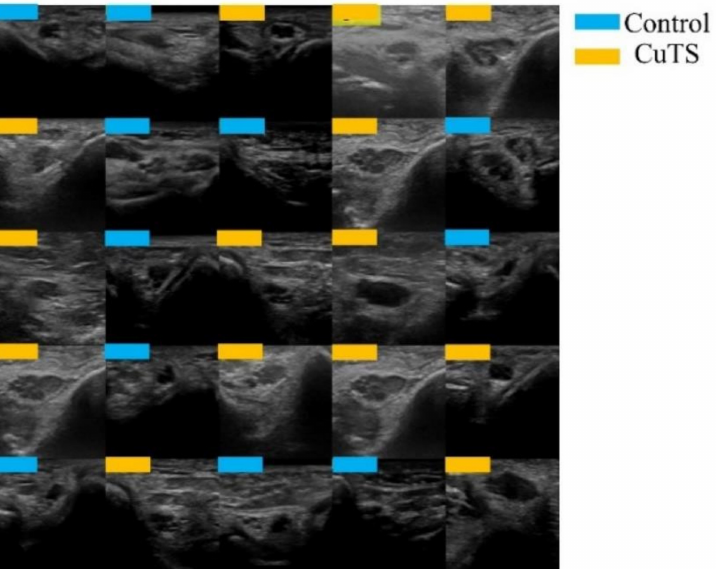
Figure 3. Images were randomly extracted by AI to be used as training data (light blue for control, orange for CuTS patients).